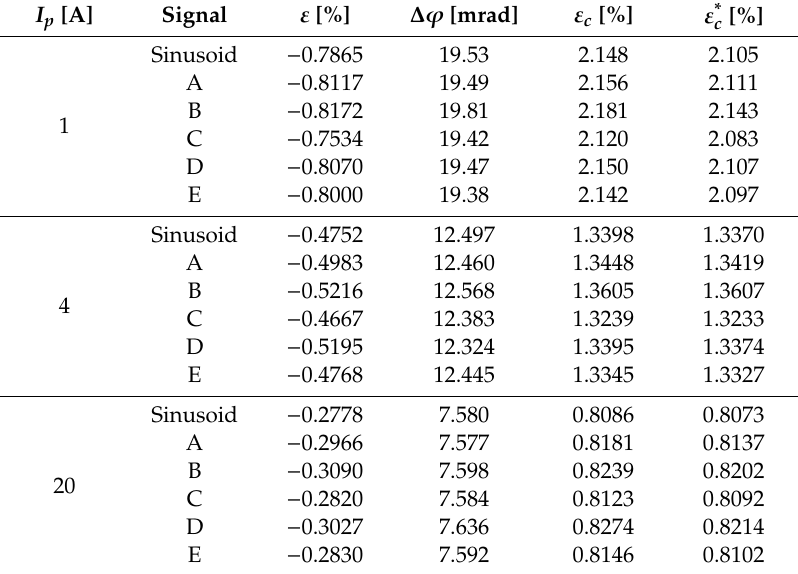
Table 6. Results for T1. Averages of ε , ∆ ϕ , ε c , ε ∗ c for the sinusoidal case and all the distorted signals, at 0.05 I pr , 0.2 I pr and I pr .